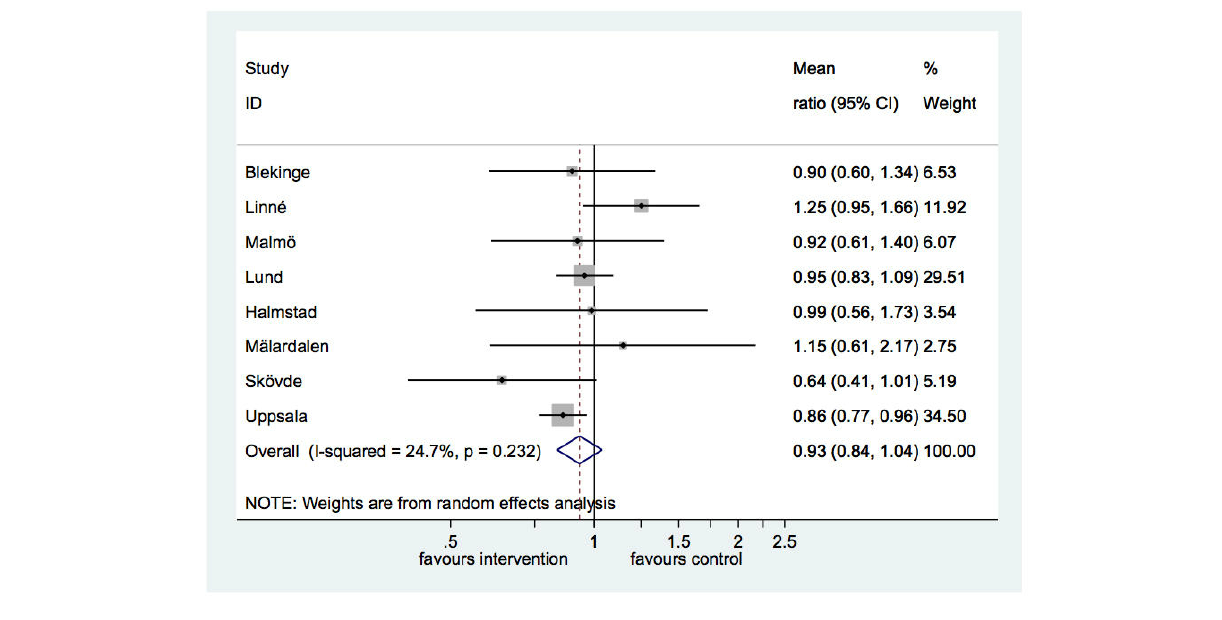
Figure 5. Forest plot of ratio of means in weekly alcohol consumption comparing intervention to